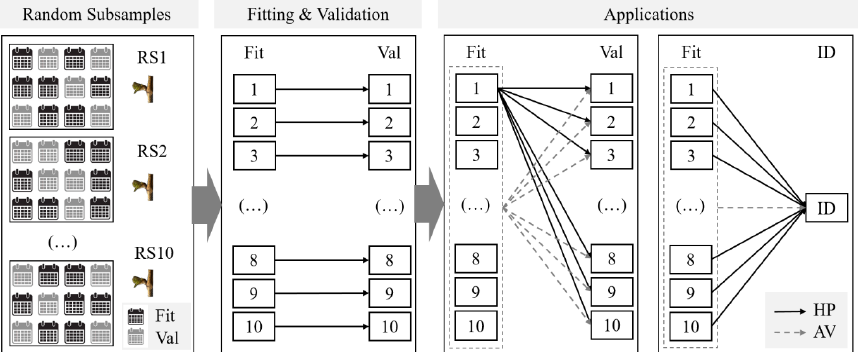
Figure 2. Workflow of the methodology adopted in this study. Random subsamples = Random distribution of the phenological observed data in subsample; Fitting and Validation = Model fitting on the selected 60% of the observed data and model validation on the remaining 40%; Applications = Model application on all validation and independent datasets. Fit = model fitting; Val = model validation; HP = highest-performance models; AV = average models; RS(n) = random subsamples; ID = independent datasets.